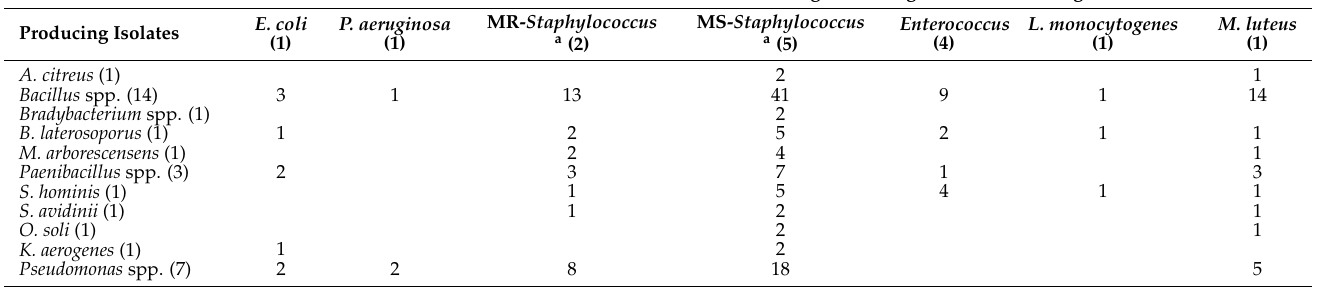
Table 3. Antimicrobial activity profile of the 32 antimicrobial-producing isolates obtained in the second screening against 15 indicator bacteria (number of isolates). Number of Positive Results of the Antimicrobial-Producing Isolates against the Following Indicator Bacteria: